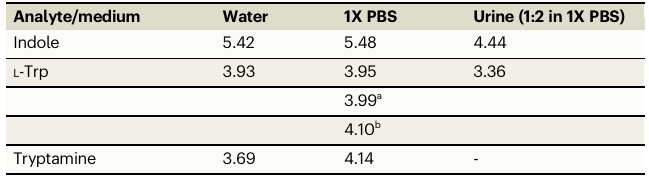
Table 2 | Binding af fi nities (log K a ) of rotaxane 1 for indoyl- based analytes in aqueous media at 25 °C